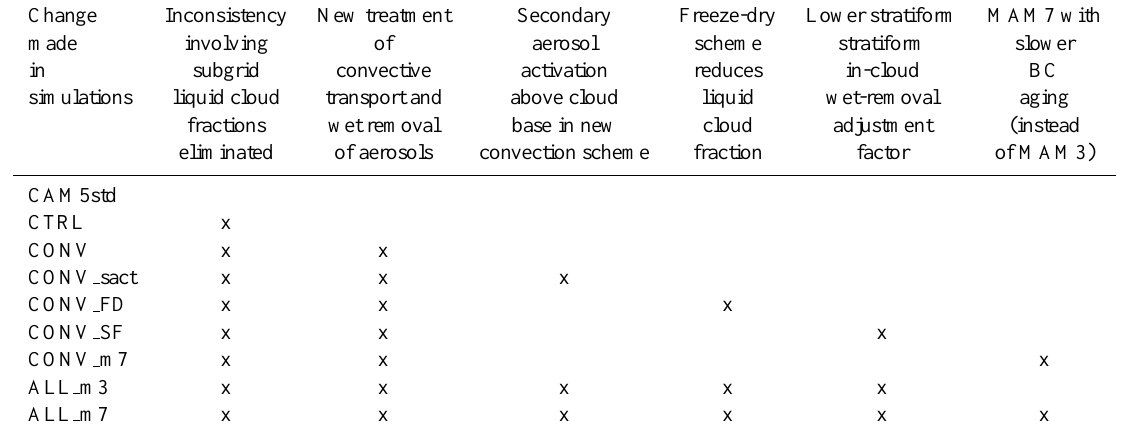
Table 1. Summary of sensitivity simulations and modifications made to the standard CAM5. Change Inconsistency New treatment Secondary Freeze-dry Lower stratiform MAM7 with made involving of aerosol scheme stratiform slower in subgrid convective activation reduces in-cloud BC simulations liquid cloud transport and above cloud liquid wet-removal aging fractions wet removal base in new cloud adjustment (instead eliminated of aerosols convection scheme fraction factor of MAM3)